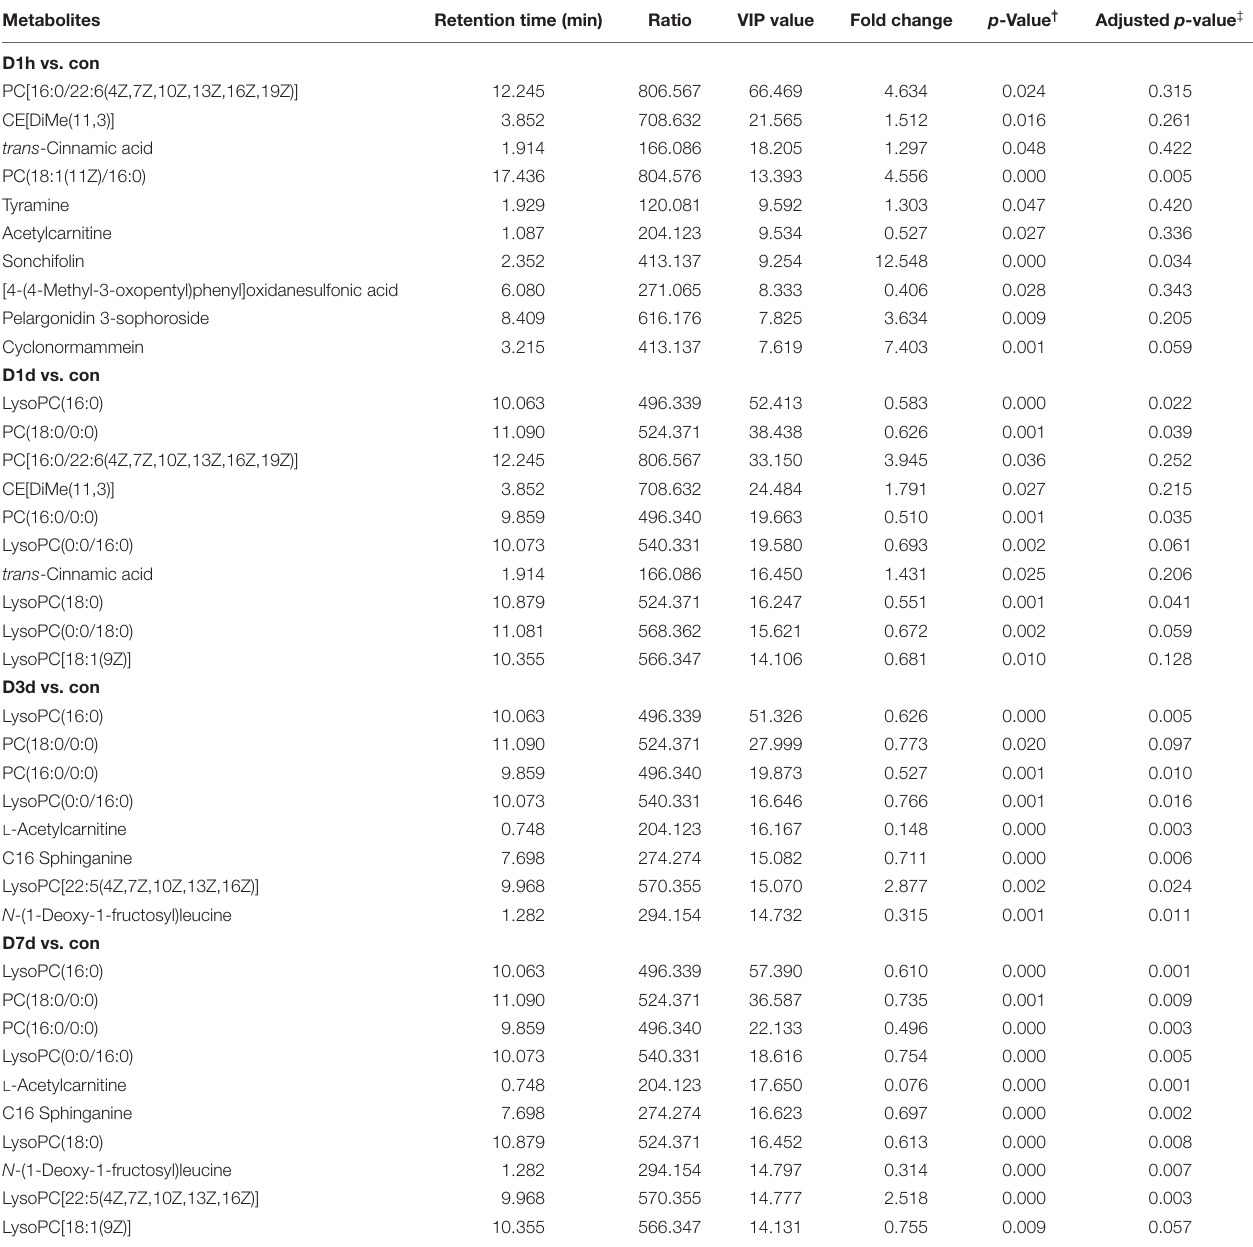
TABLE 1 | Statistical analysis of diagnostic biomarkers: discovery phase.